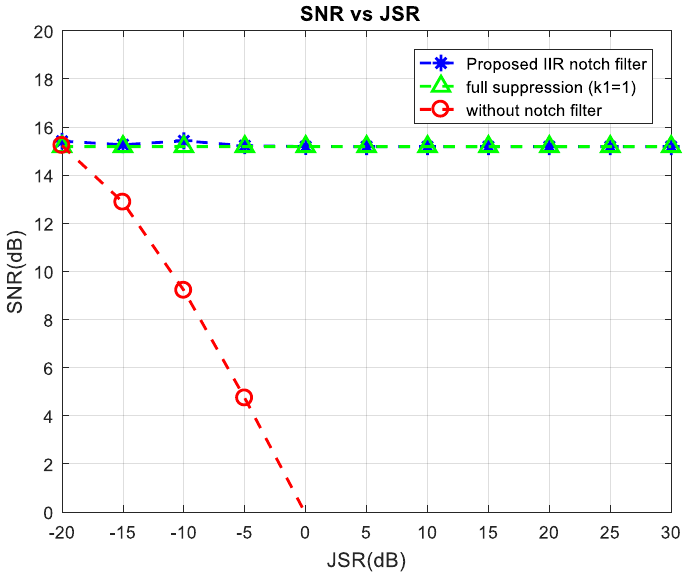
Figure 19. SNR vs. JSR, with Eb/No = 20 dB.